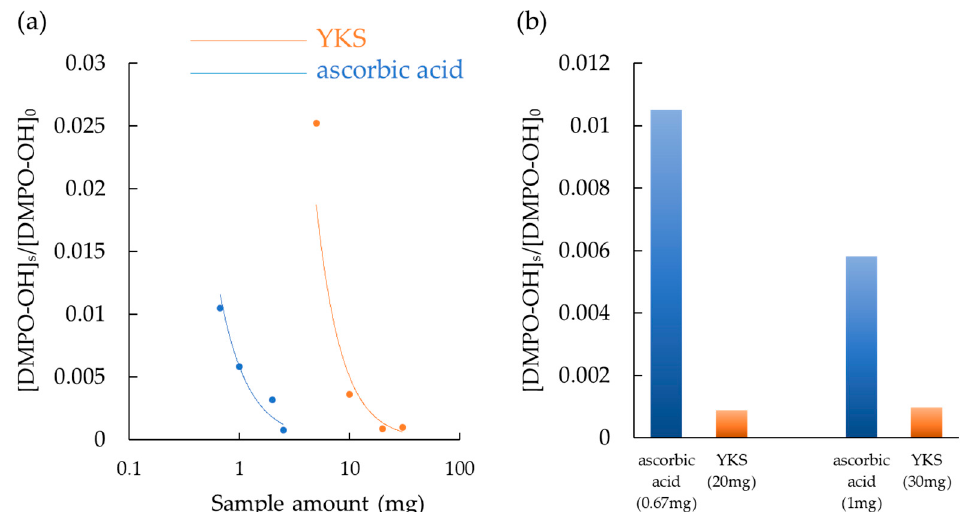
Figure 2. Hydroxyl radical ( · OH) scavenging capacity. The ratio of the radical quantity generated when YKS or ascorbic acid was added ([DMPO-OH] t ) to the radical quantity generated without YKS or ascorbic ([DMPO-OH] 0 ). ( a ) Both showed higher · OH scavenging capacity in a dose-dependent manner, with ascorbic acid higher. ( b ) YKS exhibited higher ·OH scavenging capacity when adjusted for the daily dose and compared. YKS, Yokukansan; DMPO, 5,5-dimethyl-1-pyrroline-N-oxide.